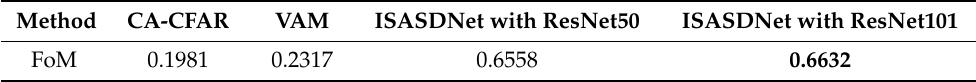
Figure 13. Experimental results on SSDD. ( a – d ) The first row contains the results of CA-CFAR. ( e – h ) The second row contains the results of VAM. Table 5. FoM on SSDD.